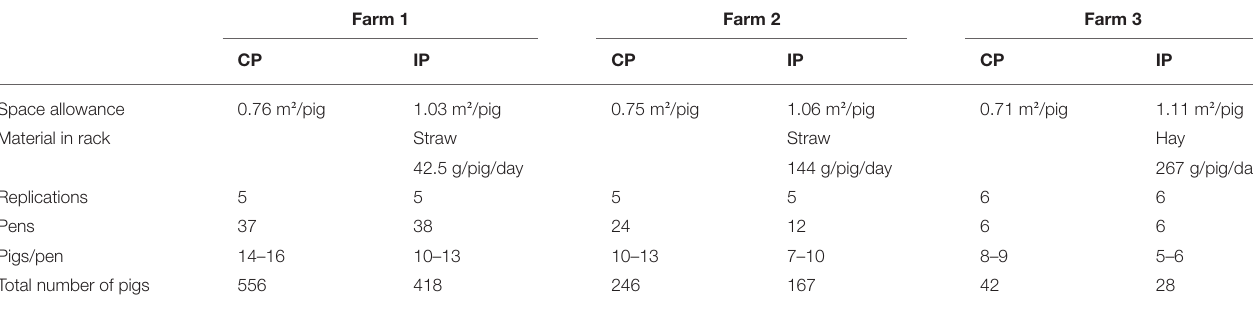
TABLE 1 | Details of intervention measures implemented on participating farms (CP, control pens; IP, improved pens).